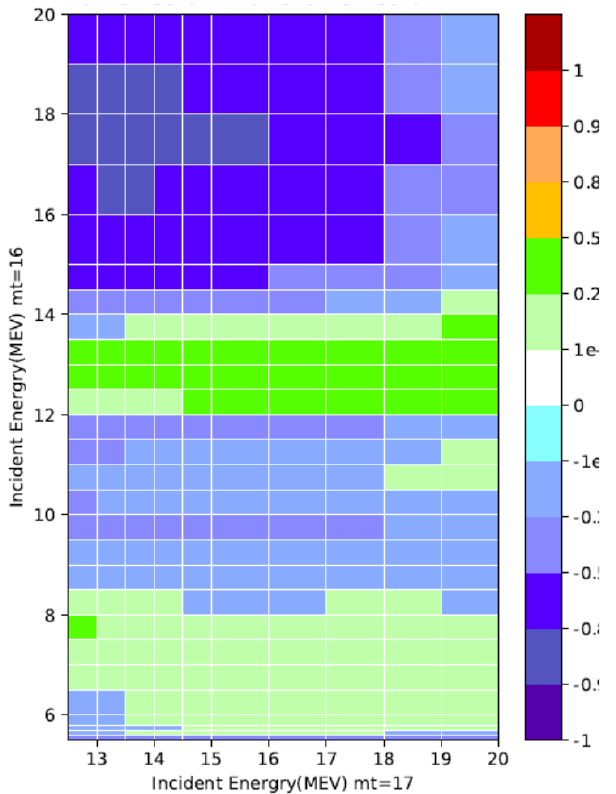
Fig. 10. The correlated coefficient of cross